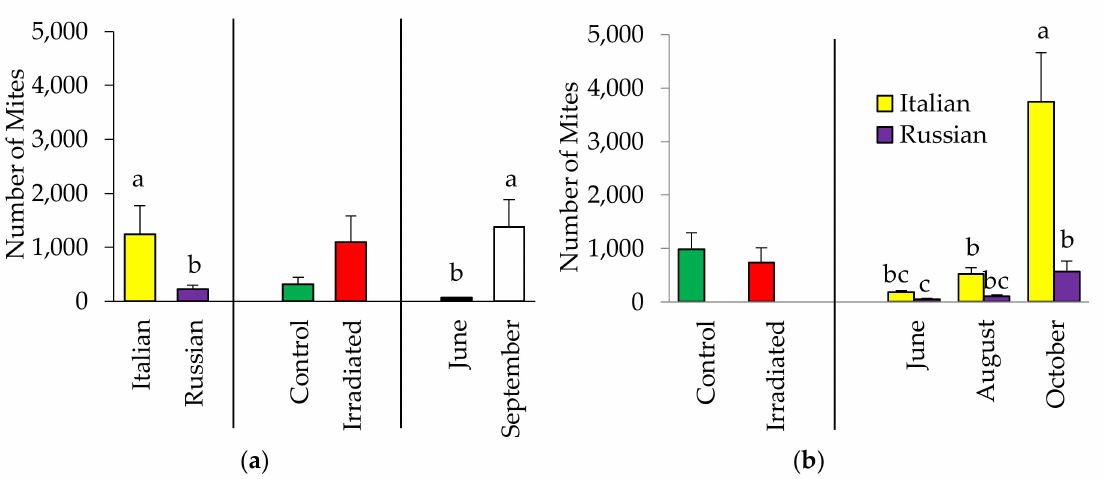
Figure 3. Total (mean ± SE) number of Varroa in Italian and Russian honey bee colonies having irradiated or non-irradiated (control) combs in ( a ) 2015 and ( b ) 2016. For each group, bars with the same letters are not significantly different ( p > 0.05); without letters indicates no